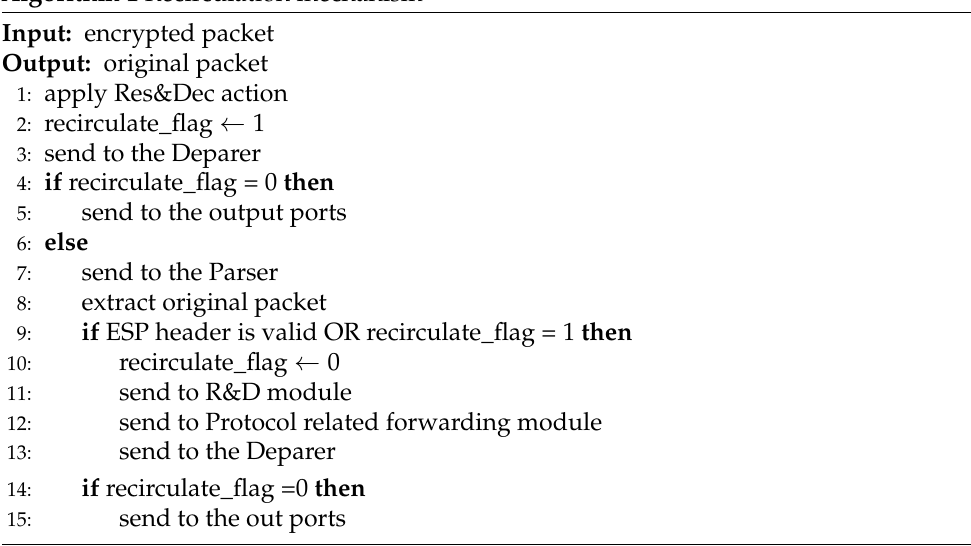
Algorithm 1 Recirculation